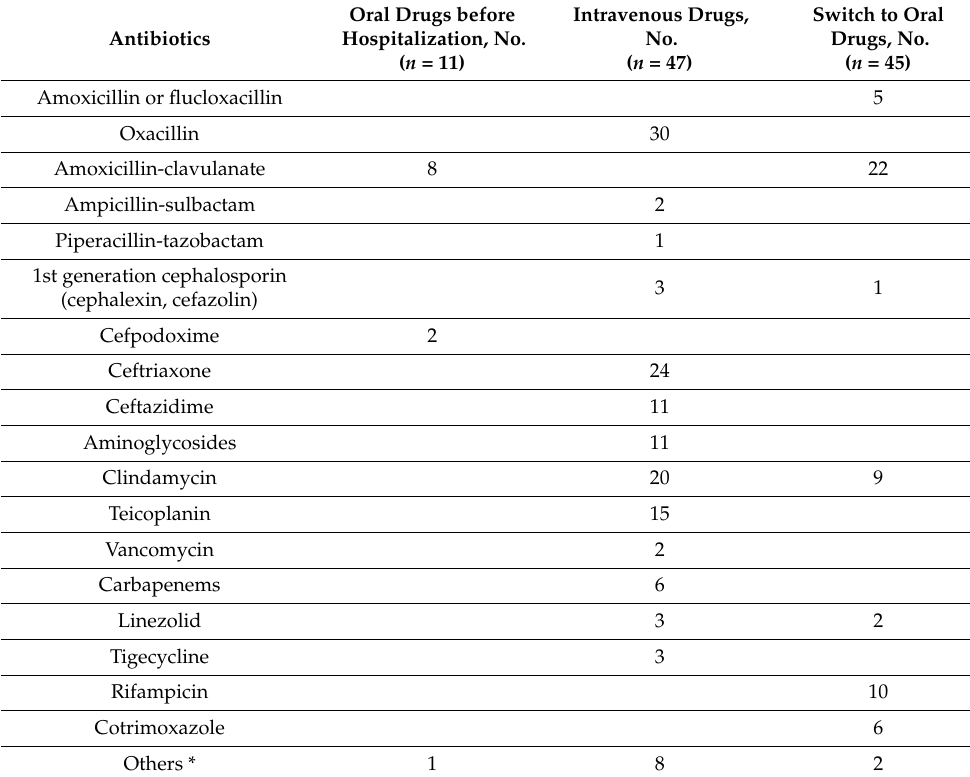
Table 3. Oral and intravenous antibiotic treatment in our 47 patients affected by pyomyositis.